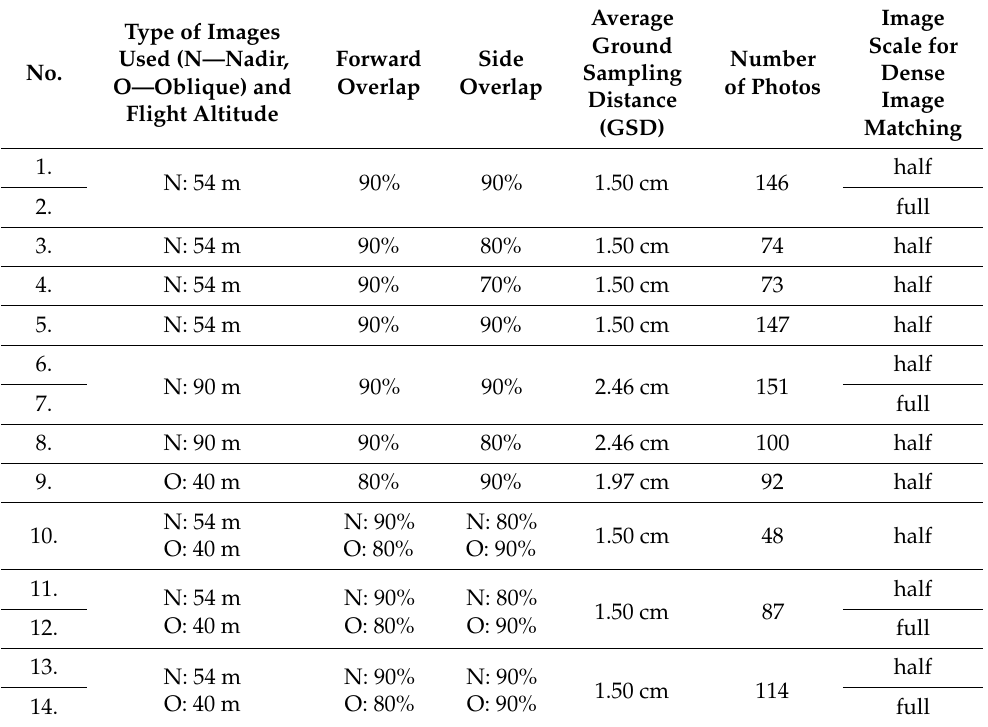
Table 1. The summary of each variant’s mission flight and processing parameters. The variants differ in flight altitude and images’ overlap. The overlap between images varies according to the mission plan, and also by managing the inputs to the data processing. All of these parameters affect average ground sampling distance (GSD) and the number of images covering a given area. The last column indicates the point cloud generation settings.